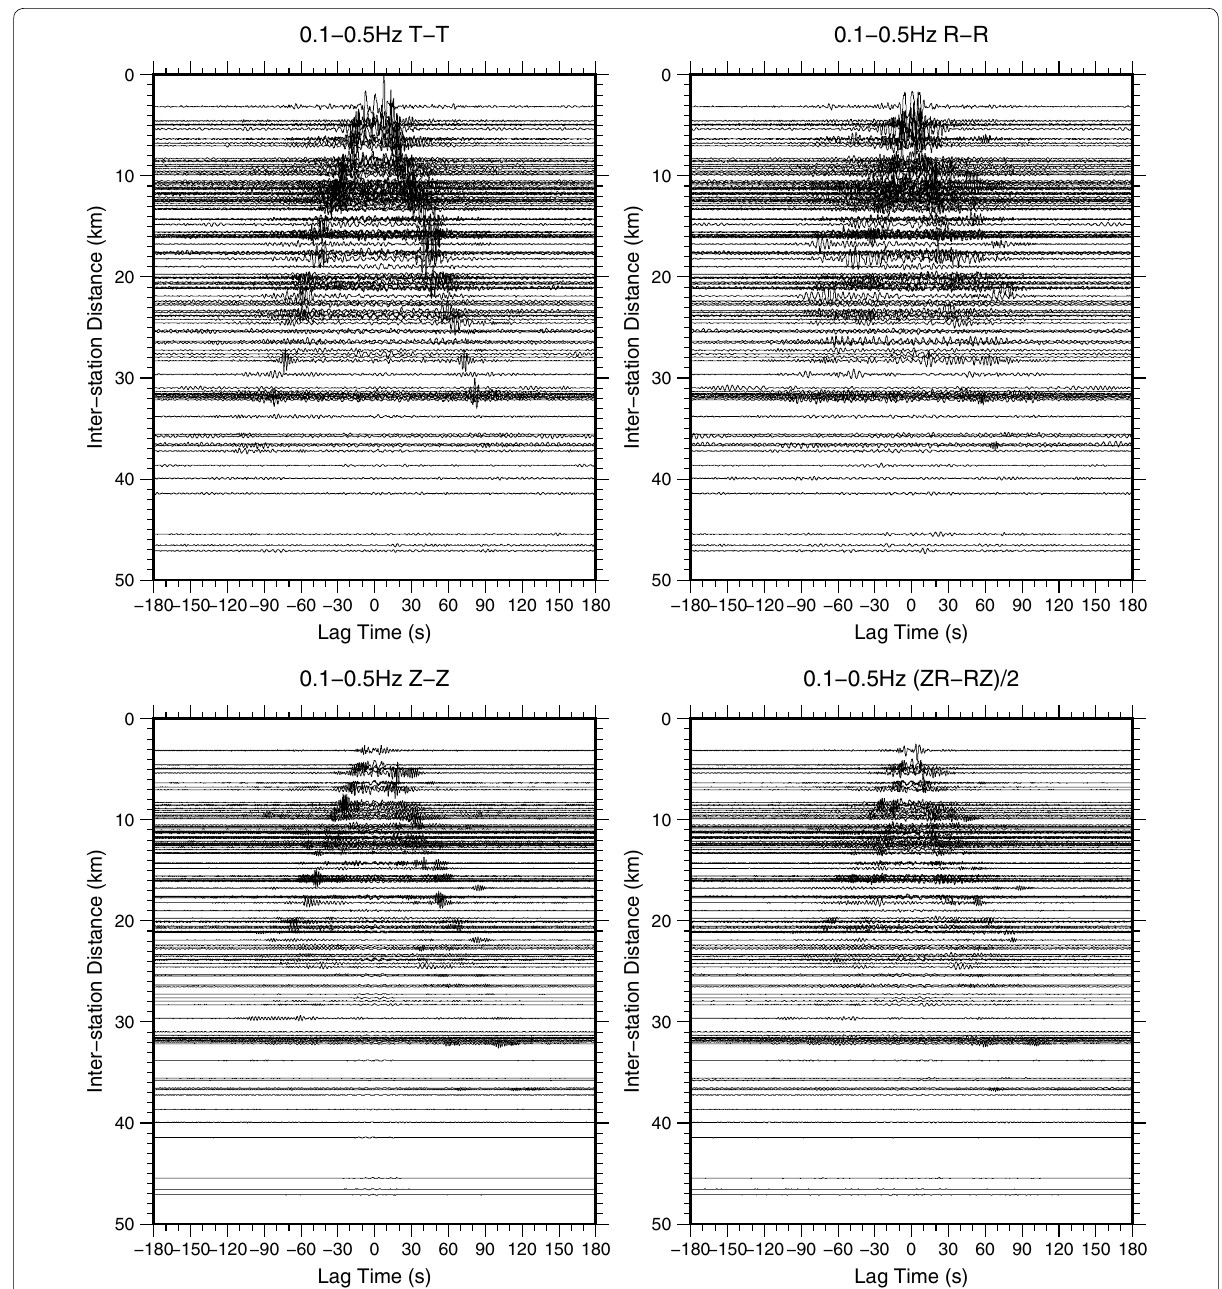
Fig. 4 Inter-station cross-correlation functions for T – T (top left), R – R ( top right ), Z – Z ( bottom left ), and ( ZR – RZ )/2 ( bottom right ) components in the frequency range 0.1–0.5 Hz for all possible station pairs ordered by inter-station